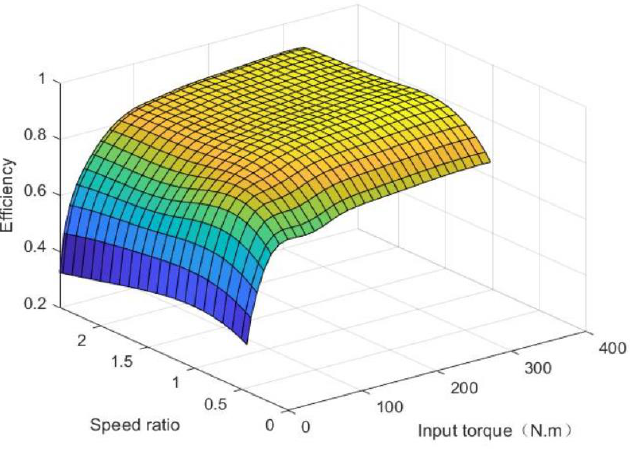
Figure 5. CVT efficiency model.